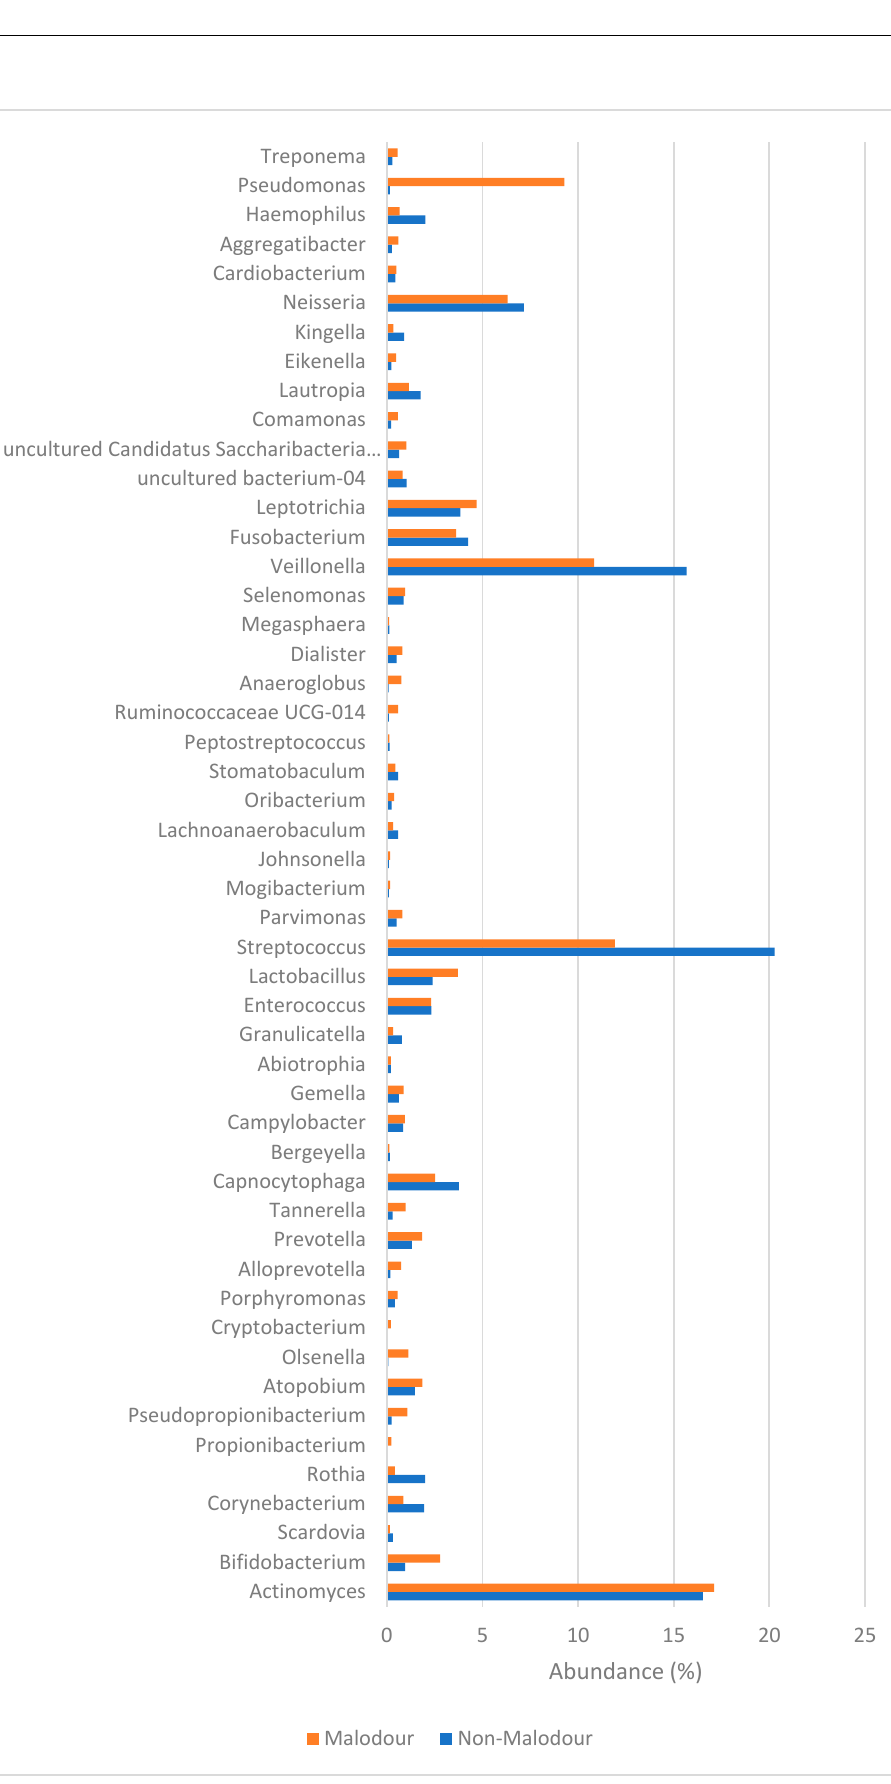
Figure 2. Microbial abundance (%) at genus level according to (red) malodor and (blue) non-malodor.